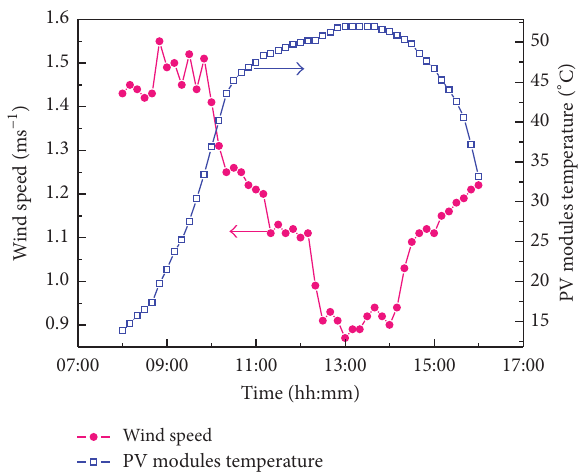
Figure 10: Voltage and current variations of